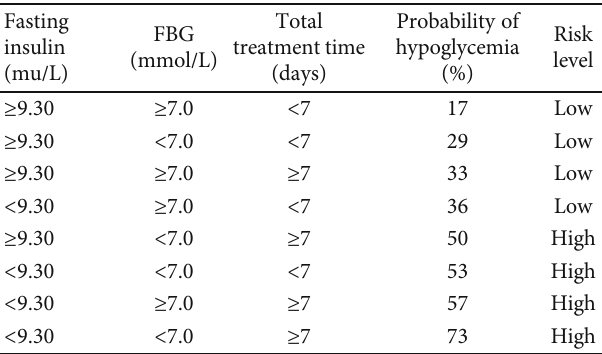
Table 3: Probability and risk level of hypoglycemia based on fasting insulin, FBG, and total treatment